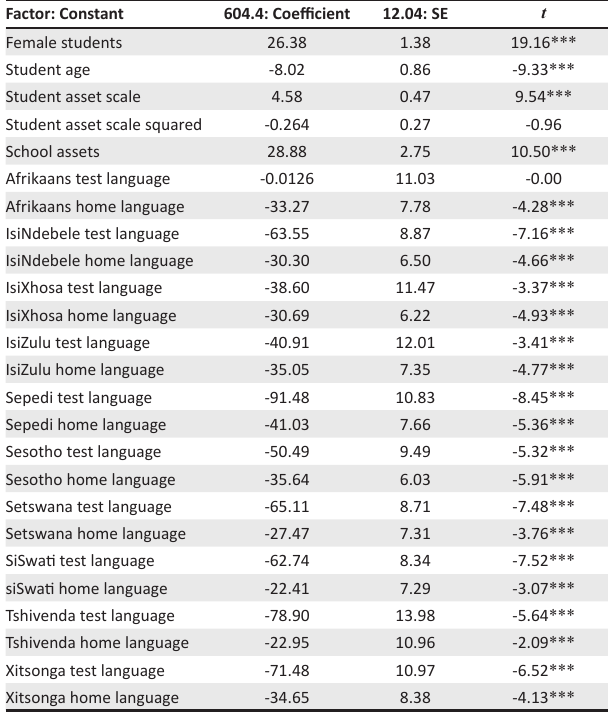
TABLE 4: Model results by students who wrote in the language of the test. Factor: Constant 604.4: